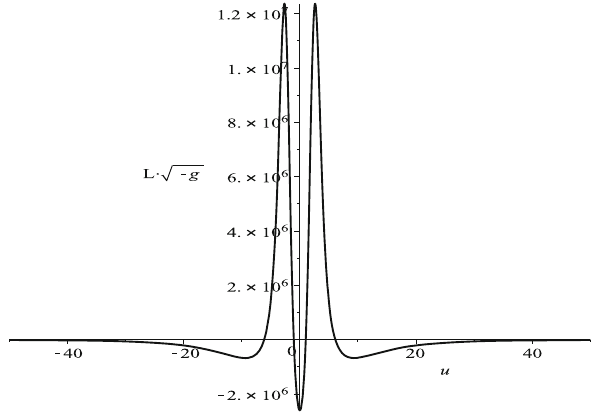
Fig. 9 Lagrangian density (the integrand in (43)) vs. the proper dis- tance coordinate u . The set of values ξ i = ξ ∗ parameters a = − 2 , b = 1 , c = − 0 . 02